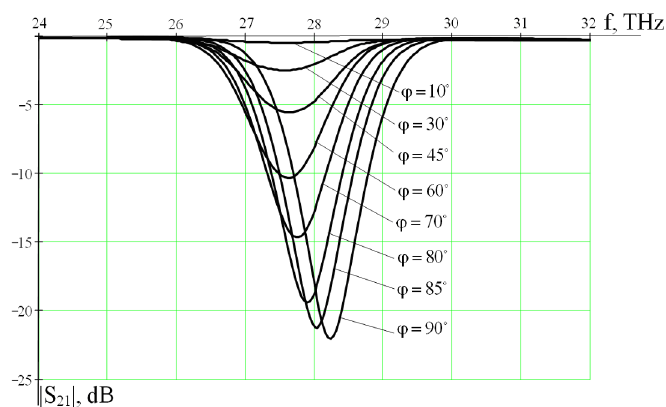
Fig. 7. Frequency dependences of transmittance coefficient |S 21 | through THz polarizer based on the resonance metasurface of single rectangular graphene strip in the unit cell on the dielectric substrate for different angles φ of orientation of the electric field E of incident TEM -wave respective to graphene strip: μ с = 0.57 eV; a = 2 μ m, b = 0.2 μ m, w = 0.1 μ m, l/a = 0.9, h = 0.5 μ m, ε = 2.2.